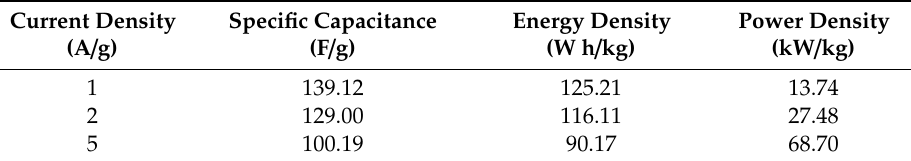
Figure 7. ( a ) SEM image of the AS electrode (ZnO/CNT/FP) after bending. ( b ) SEM image of the AS electrode (Fe 3 O 4 /CNT/FP) after folding. Figure 8. Rate stability of the AS and the application of powering the LED light (40 mW).